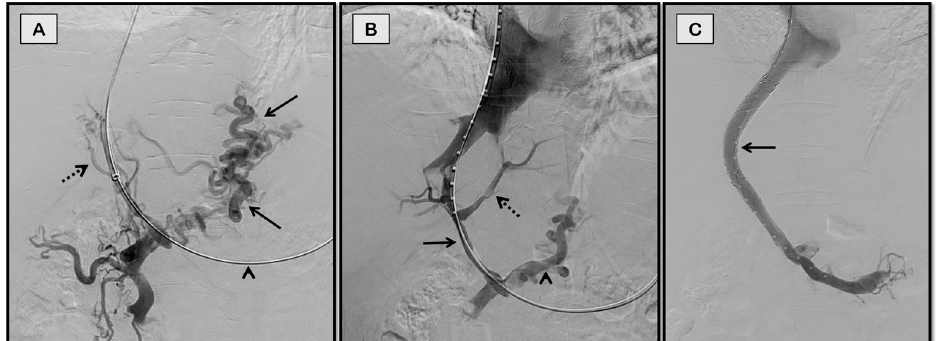
Figure 5. Trans-splenic access for TIPS for recurrent variceal bleeding in a 72-year-old man with chronic portal vein thrombosis secondary to NASH-cirrhosis. Fluoroscopic spot image ( A ) of splenoportal angiogram obtained after gaining through-and-through access between jugular and trans-splenic puncture sites (arrowhead) shows completely thrombosed portal vein with periportal collaterals (dashed arrow) and tortuous left gastric vein giving rise to esophageal varices (solid arrows). Post balloon maceration and thromboaspiration ( B ), there is partial recanalization of the main portal vein (solid arrow) and its intrahepatic branches (dashed arrow), but the persistent filling of the left gastric vein (arrowhead). Image ( C ) shows optimal contrast flow through the TIPS stent with the disappearance of collaterals.